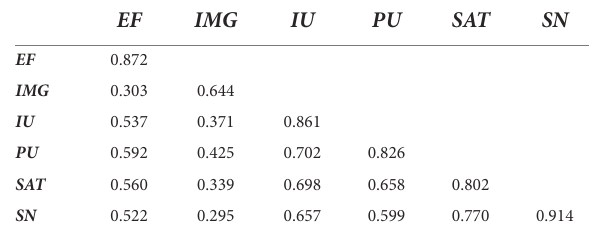
TABLE 2 Inner model evaluation. TABLE 3 Discriminant validity.